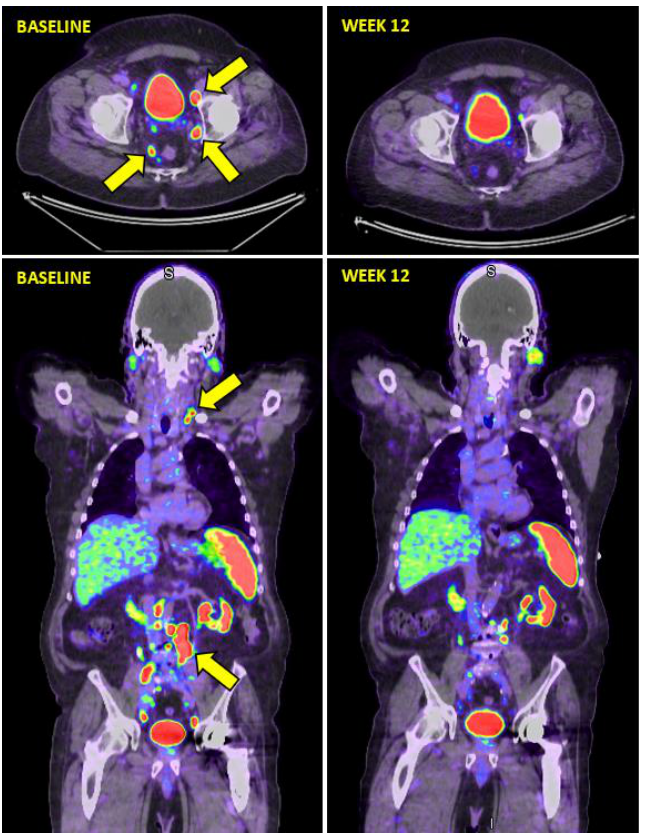
Figure 2. Example of week-12 68 Ga-PSMA-11 PET/CT response assessment following 177 Lu-PSMA I&T for mCRPC. Baseline 68 Ga-PSMA-PET/CT (left panels) nodal metastases involving left cervical chain and multiple abdominopelvic nodes (yellow arrows). Week-12 68 Ga-PSMA-PET/CT response assessment (right panels) showing a near complete response with resolution of the majority of nodal disease above and below the diaphragm. Consistent with an excellent partial remission.